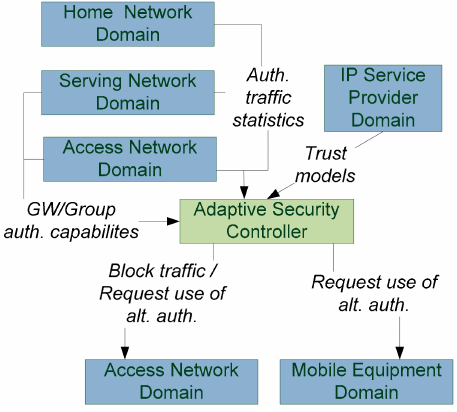
Figure 5. Domains and information in the authentication storm scenario. GW: